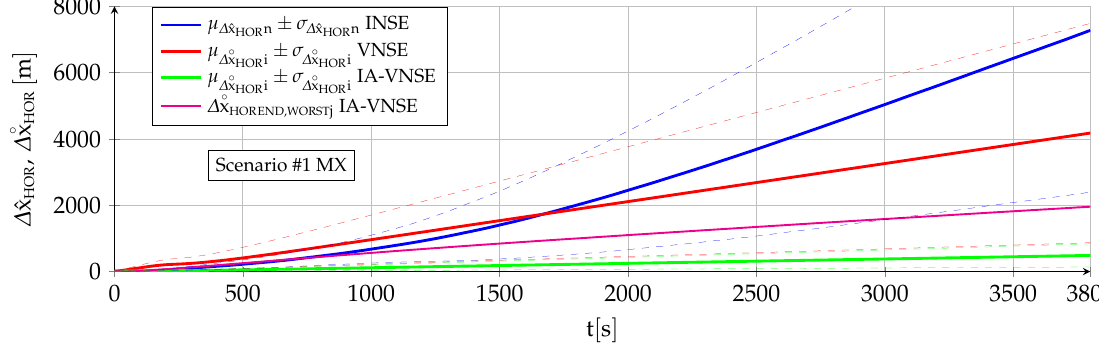
Figure 13. Horizontal position INSE, VNSE, and IA-VNSE for scenario #1 MX (100 runs). The IA-VNS (green lines) results in major horizontal position estimation improvements over the VNS. The final horizontal position error mean µ diminishes from 3.82 END ∆ ◦ x HOR to 0.46 % for scenario #1, and from 1.77 to 0.23 % for scenario #2. The repeatability of the results also improves, as the final standard deviation σ falls from 2.73 to 0.31 % END ∆ ◦ x HOR and from 1.48 to 0.18 % for both scenarios. Note that although these results may be slightly optimistic due to the optimized image generation process, they are much more accurate than those obtained with the INS, for which the error mean and standard deviation amount to 7.10 and 5.69 % for scenario #1, and 1.52 and 0.86 % in case of scenario #2.